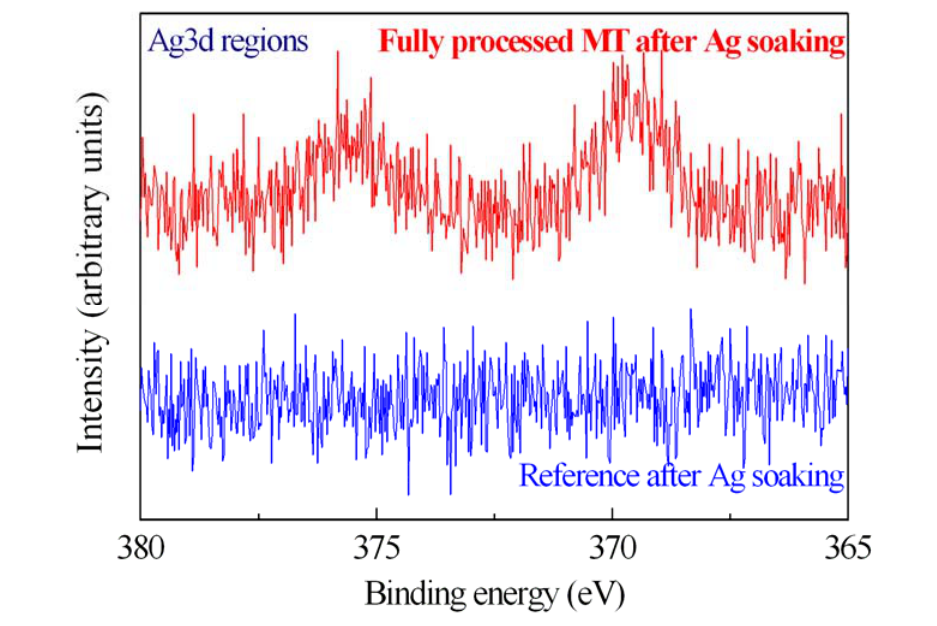
Figure 8. XPS spectra of Ag 3d regions for the samples: full MT (500 μ g/mL, red line) reference (blue line) after Ag soaking.